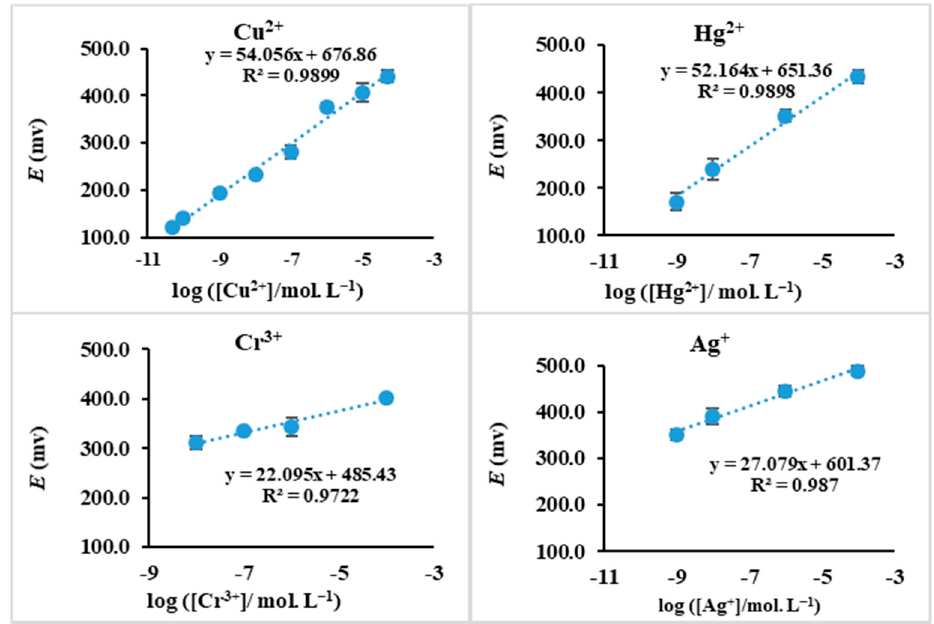
Figure 2. Calibration curves for Cu 2+ , Hg 2+ , Cr 3+ and Ag + ions with UCPE. Experimental conditions: 0.1 mol · L − 1 KNO 3 in 0.1 mol · L − 1 HAc-NaAc buffer pH 5.0, room temperature, 6B pencil as a pseudo-reference electrode and CPE (72 wt % of graphite powder and 28 wt % of Nujol oil) as an indicator electrode.